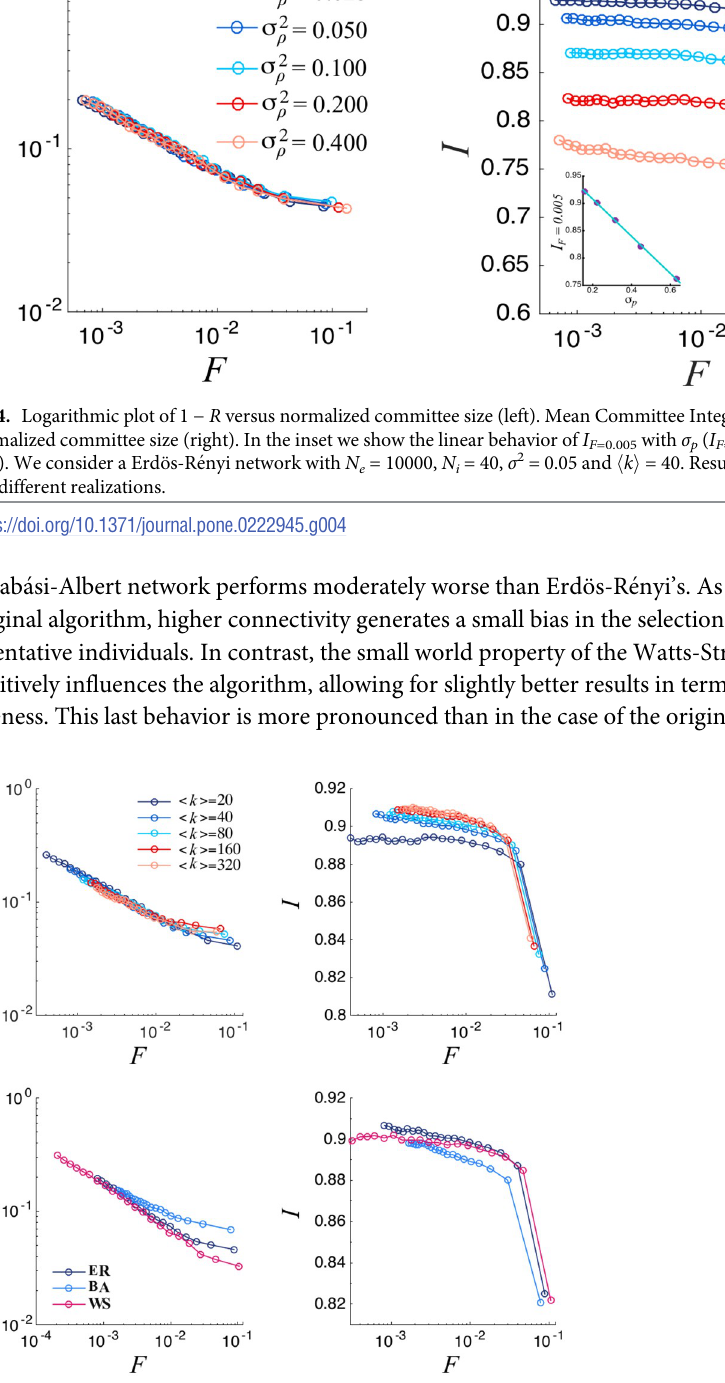
= 40, h k i = 40 and s 2 ¼ s 2 ¼ 0 : 05 . Results i p